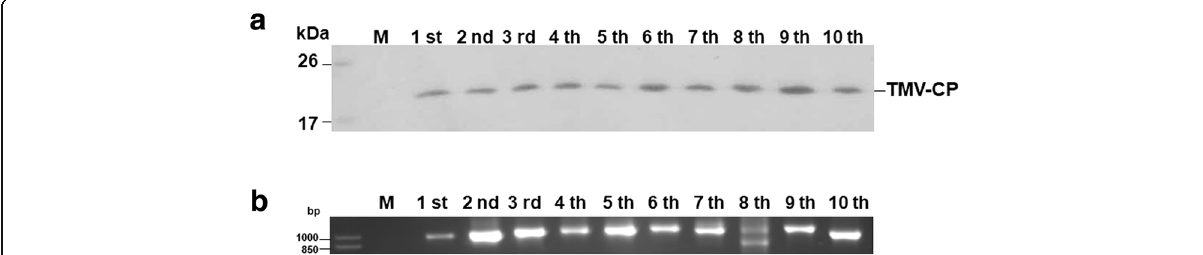
Fig. 3 a Detection of TMV (24A + UPD) coat protein (CP) in inoculated plants during 10 rounds of serial passaging. b Detection of PCR products of approximately 1 kb in size from 10 rounds of serial passaging of TMV (24A + UPD). M represents